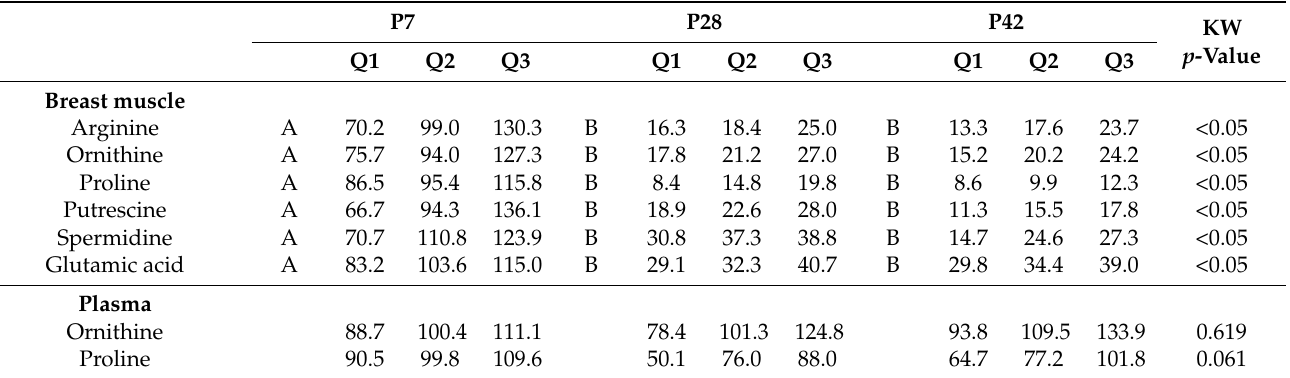
Table 6. Levels of polyamines and related amino acids during post-hatch developmental period in